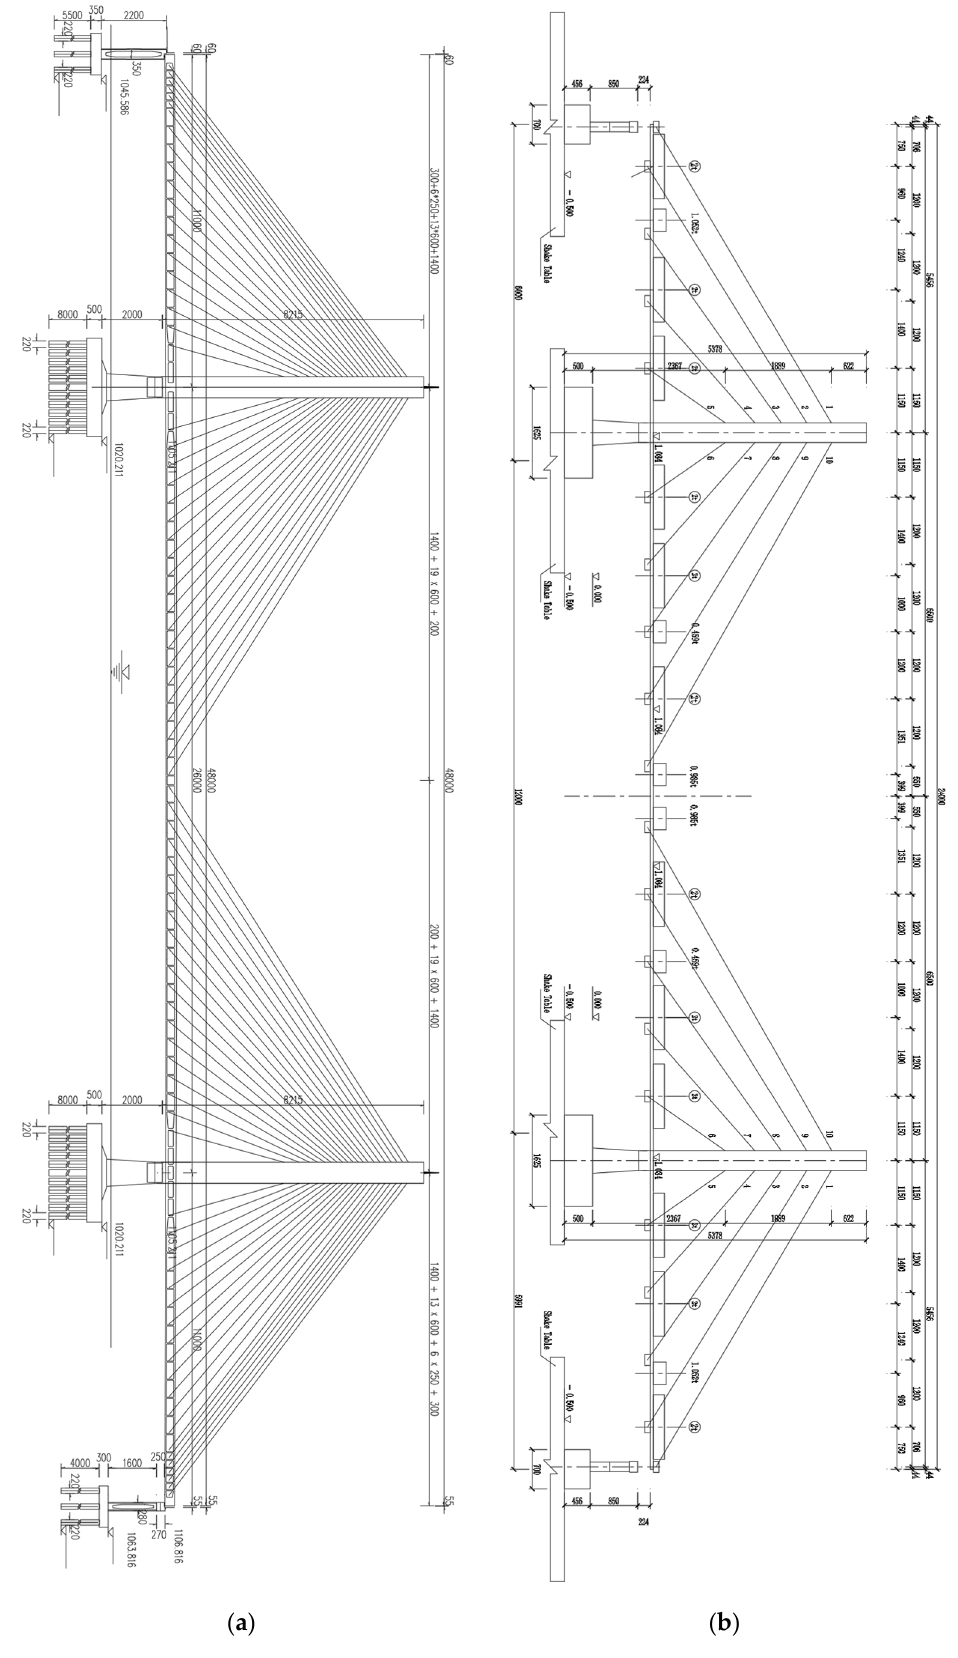
Figure A2. Elevation view (unit: mm): ( a ) bridge prototype; ( b ) bridge model.